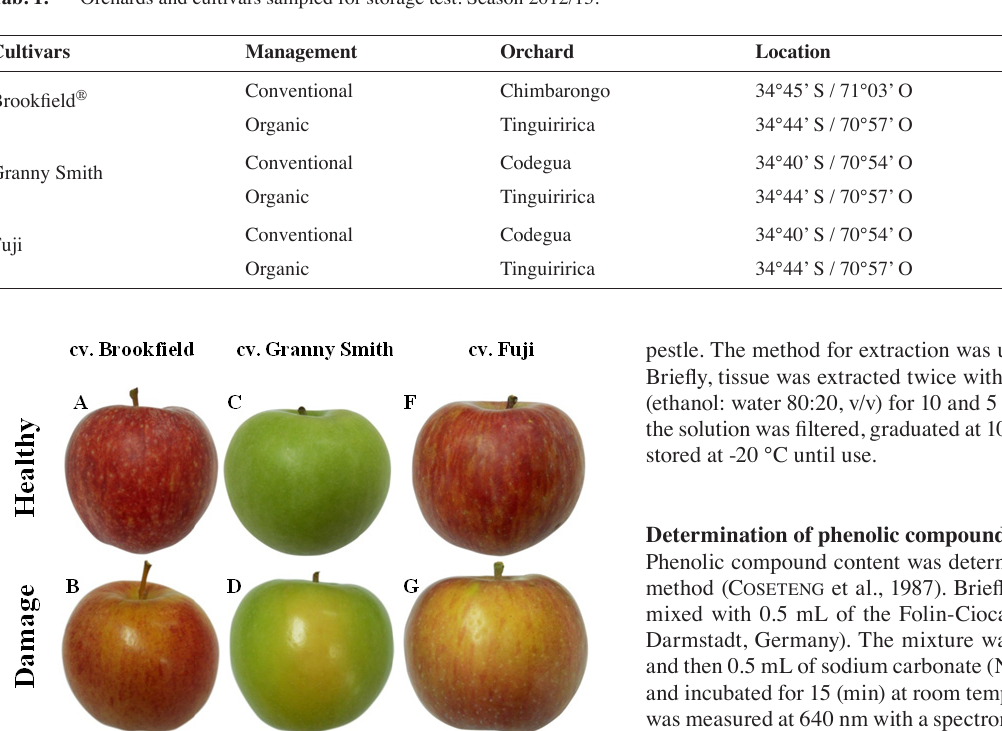
Tab. 1: Orchards and cultivars sampled for storage test. Season